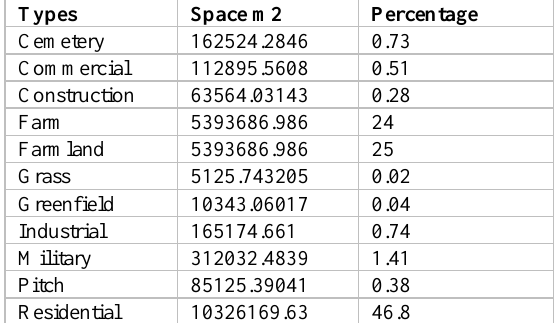
Table 7 : Spaces of Land use and cover types